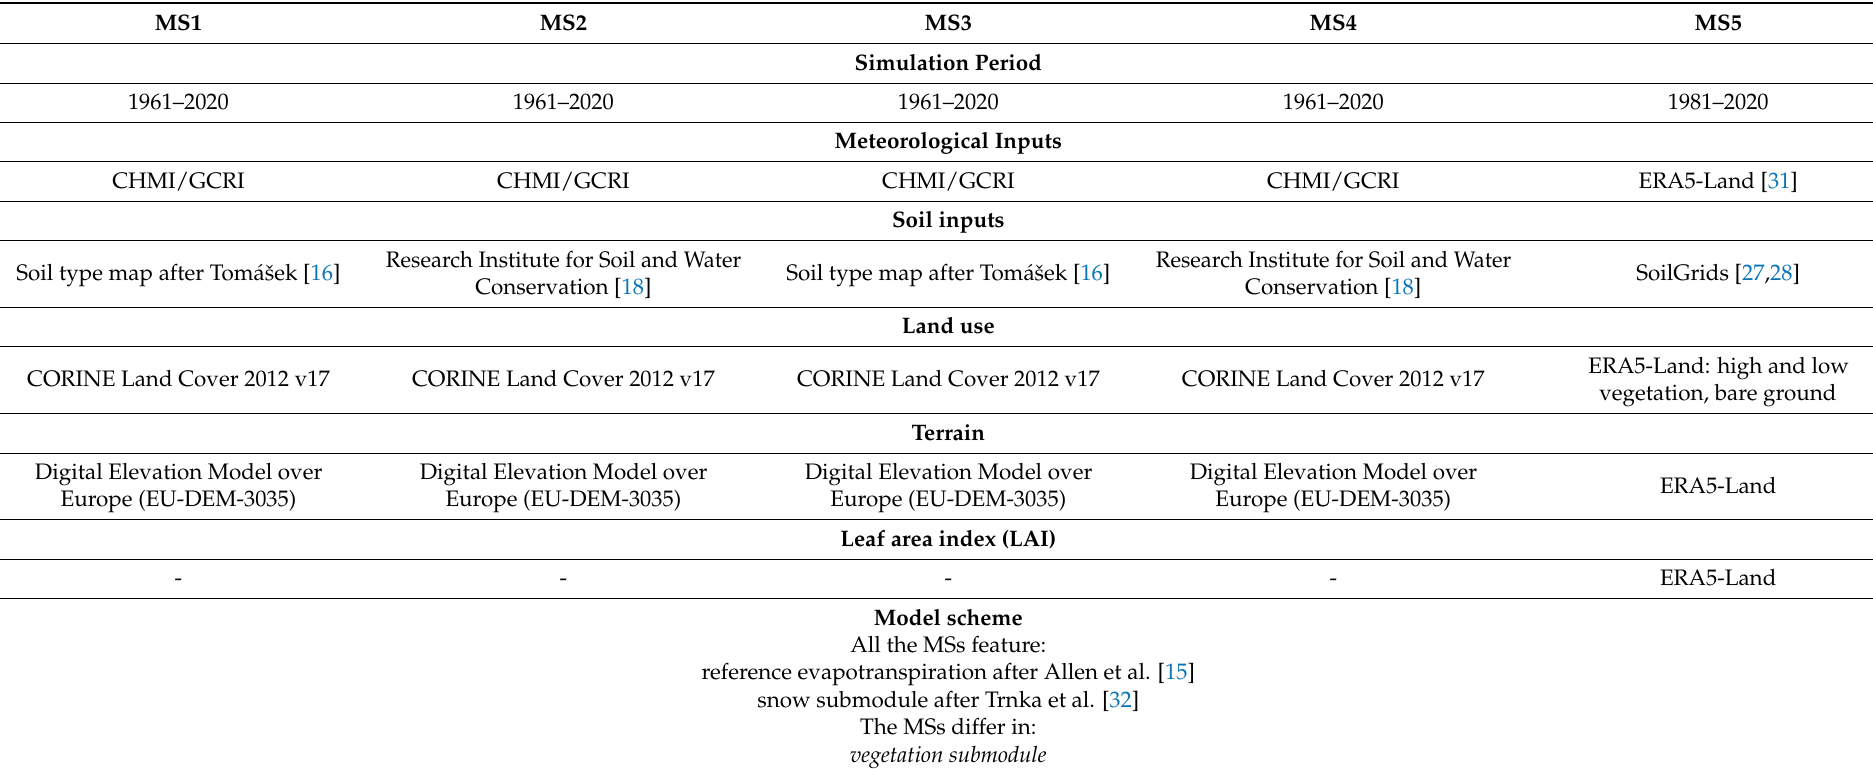
Table A1. Basic features of the model setups MS1–MS5 employed for the calculation of the soil moisture. Abbreviations: AWR—relative soil saturation; CHMI—Czech